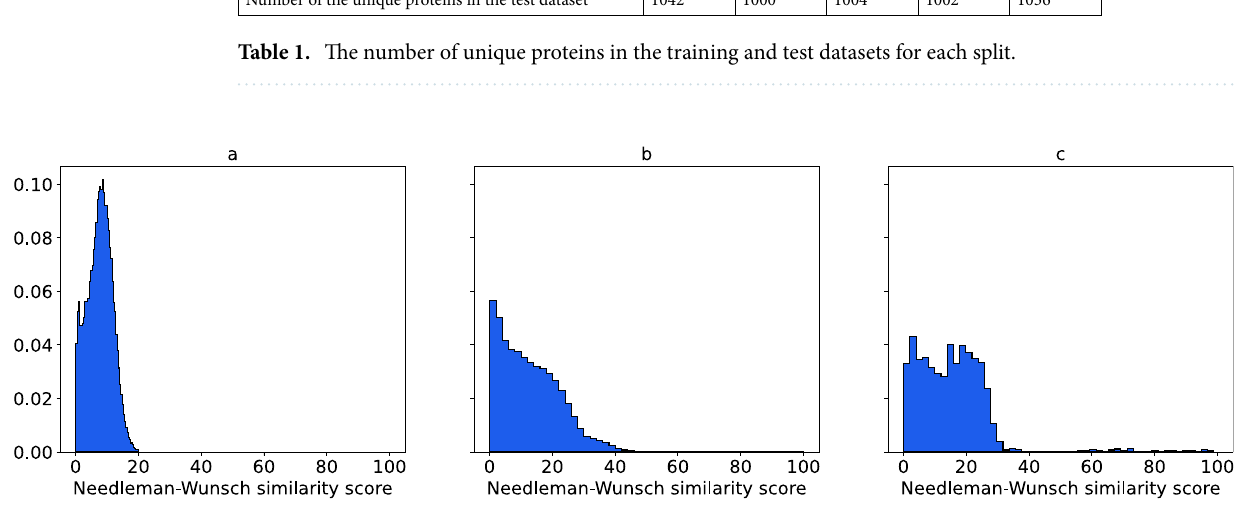
Figure 1. Distributions of sequence similarities between proteins used for model training and validation. ( a ) Sequence similarities between proteins in the test dataset and the ones in the training dataset, ( b ) sequence similarities of proteins within the test dataset, ( c ) sequence similarities of proteins within the training